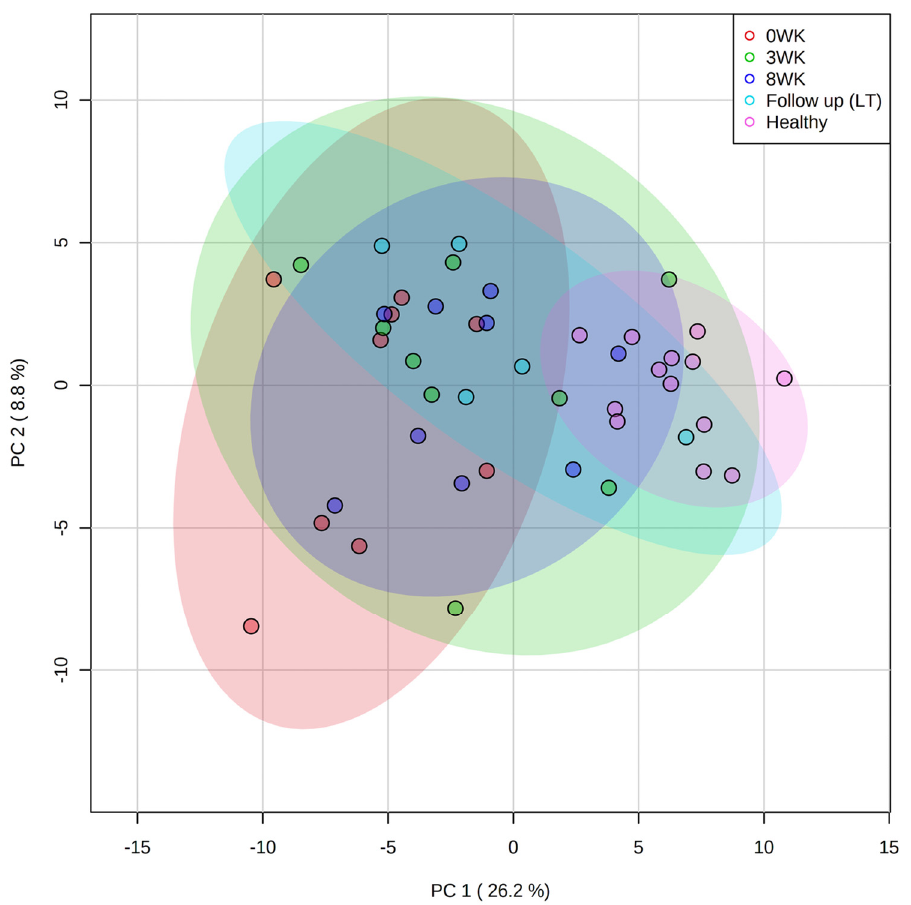
Figure 4. Fecal untargeted metabolomics. PCA plot showing healthy controls (pink dots) being tightly clustered, while samples from dogs with SRE are spread out at baseline (red dots). Shaded ellipses indicate the confidence intervals, with samples becoming progressively more clustered and closer to HC at 3 weeks (green dots), 8 weeks (blue dots), and long-term (LT, 1-year, cyan dots) follow up.